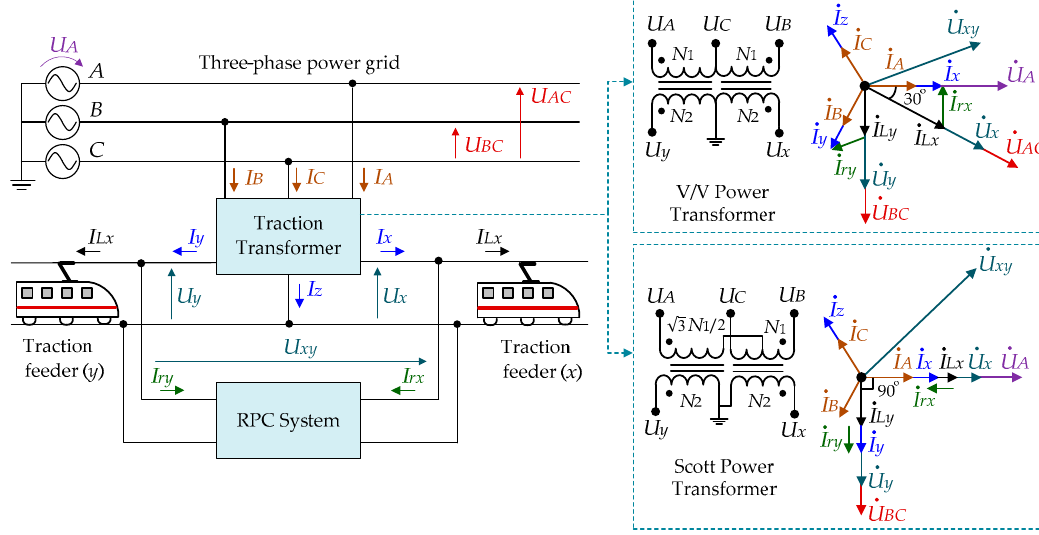
Figure 18. RPC system and phasor diagrams in V/V and Scott power transformer (based on [10,48]).